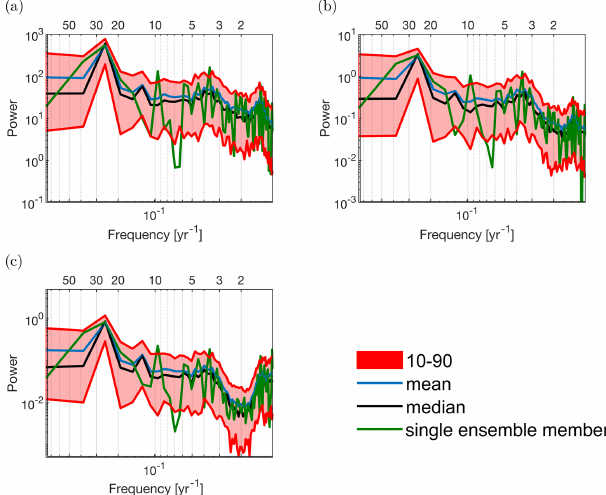
Figure 11. Spectral analysis for variables (a) T 1 , (b) S 1 , and (c) δ for the PFB case (both subsurface fluxes). The analysis is based on 100 ensemble members. Each ensemble member contains the last 75 years of a 100-year run to exclude spin-up effects. The red band represents the ensemble members between the 10th and 90th percentile. The mean (blue), median (black), and a single ensemble member (green) are also displayed. Both axes are on a log scale. The top x axis displays the period in years, and the bottom x axis shows the frequency per